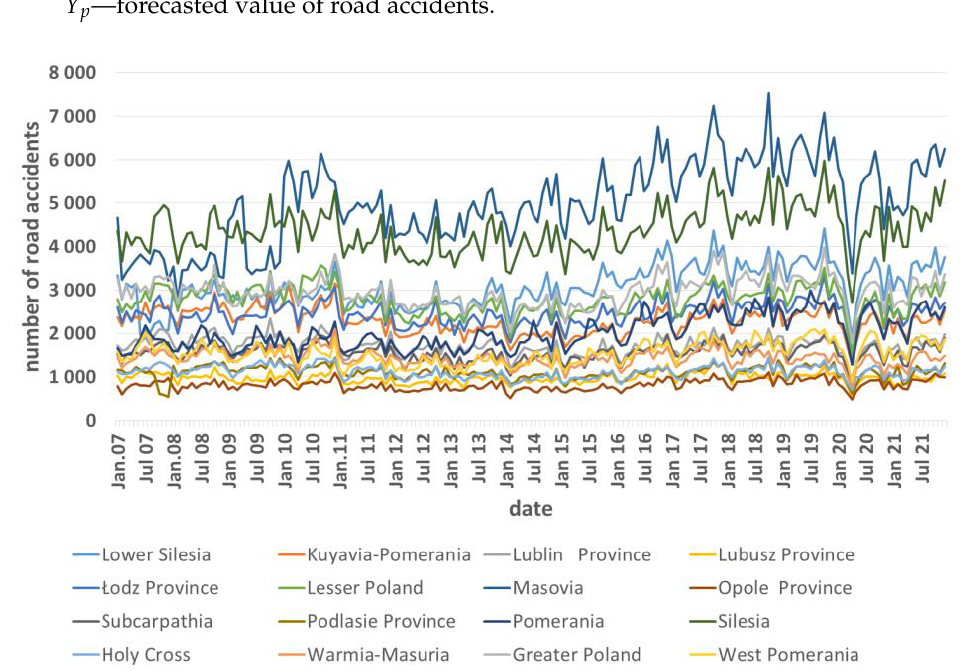
Figure 4. Number of road accidents in Poland by province from 2001 to 2021 [60].